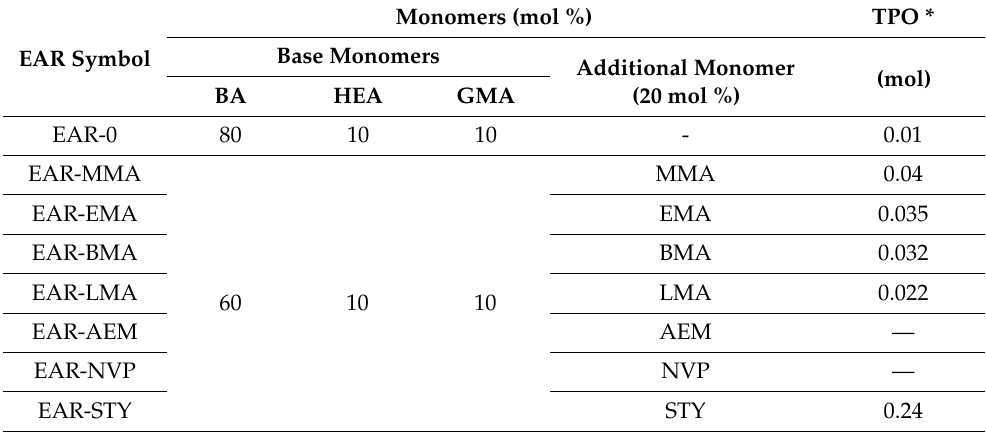
Table 2. Compositions of monomers and photoinitiator for preparation of epoxy acrylic